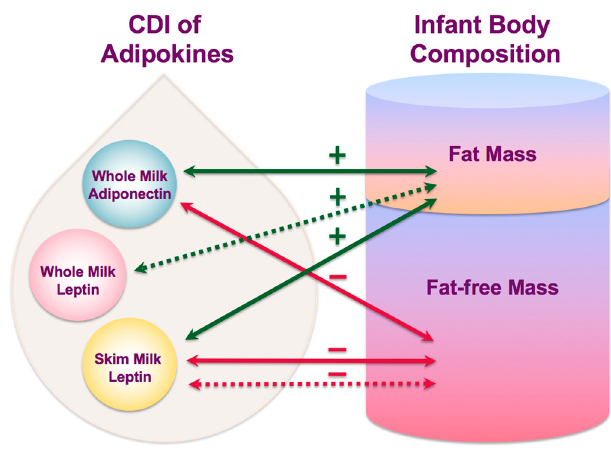
Figure 4. Interconnecting pathways of lactocrine programming of the infant body composition as researched. Solid arrows indicate associations of calculated daily intakes of adipokines with measured body composition parameters and dotted arrows indicate associations with changes in body composition between time points (green—positive associations; red—negative associations). CDI—calculated daily intakes.